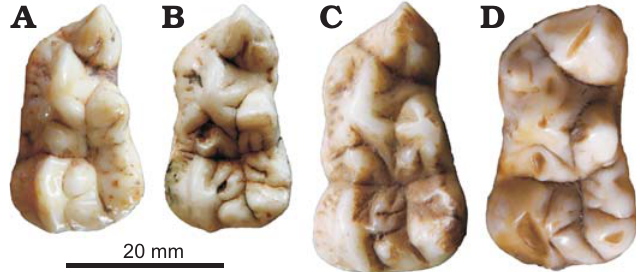
Fig. 10. Occlusal views of large entoconid 2 of Ailuropoda spp. A , B . Ailu- ropoda wulingshanensis Wang and Lin, 1982 from Longgudong Cave, Jiangshi, China, middle Early Pleistocene. A . IVPP V13459.11. B .